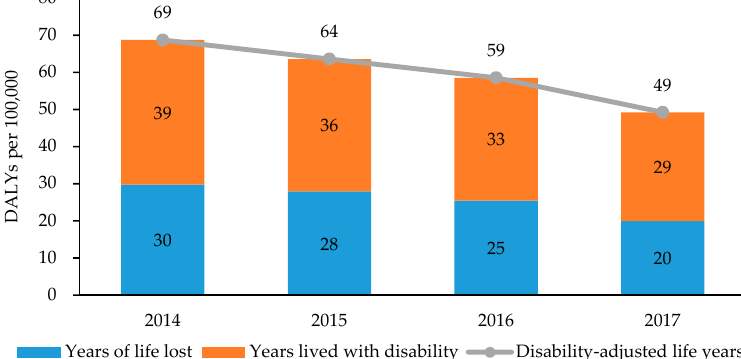
Figure 1. Years of life lost, years lived with disability, and disability-adjusted life years due to tuberculosis in Korea, 2014–2017.